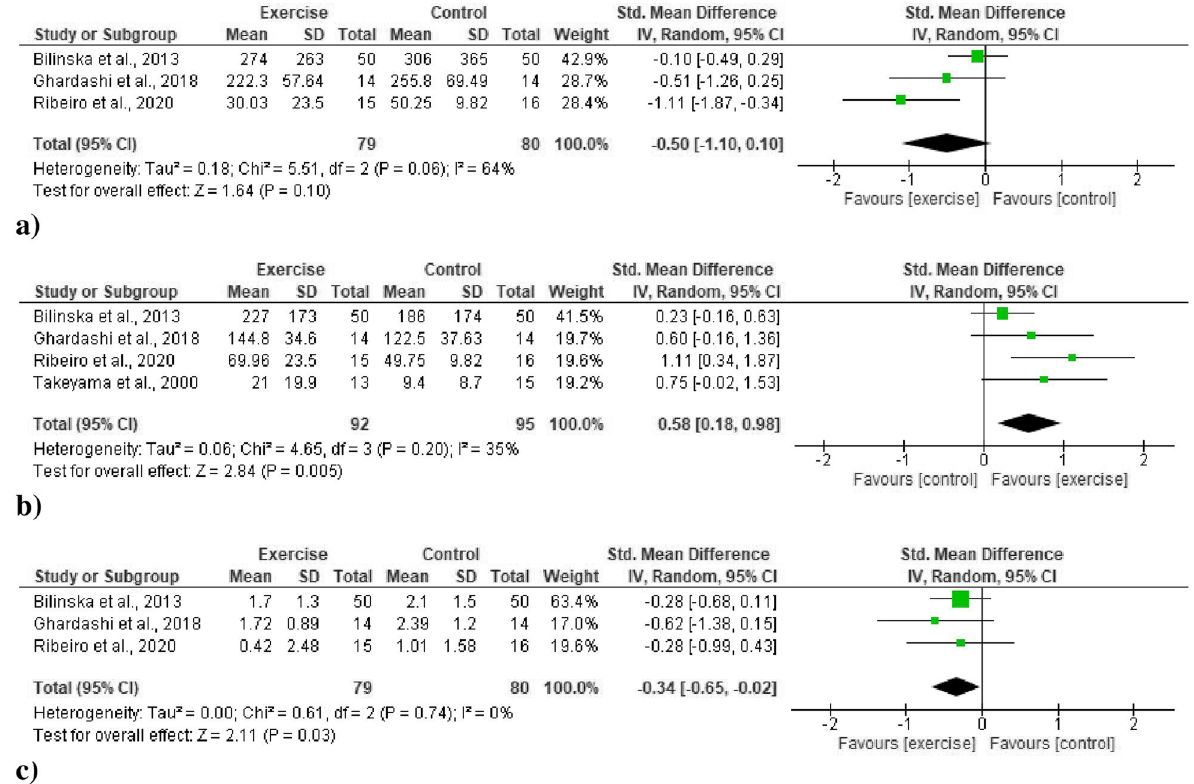
Fig. 3 Forest plots for frequency domain HRV indices. - a Overall changes in standardized mean difference indices for low frequency (LF). b Overall changes in standardized mean difference indices for high frequency (HF). c Overall changes in standardized mean difference indices for LF/HF